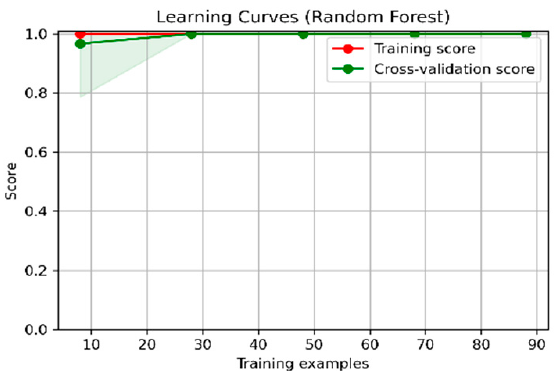
Figure 8. Learning curve for the random forest model for data from 2022. Table 5. Results from complex forecasting models for sequential feature extraction from data for 2021, without feature selection.